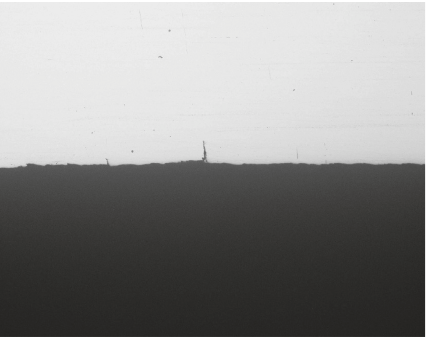
Figure 10: Micromorphology of small cracks. Figure 11: Magnified micromorphology of small distributed cracks in fracture origin